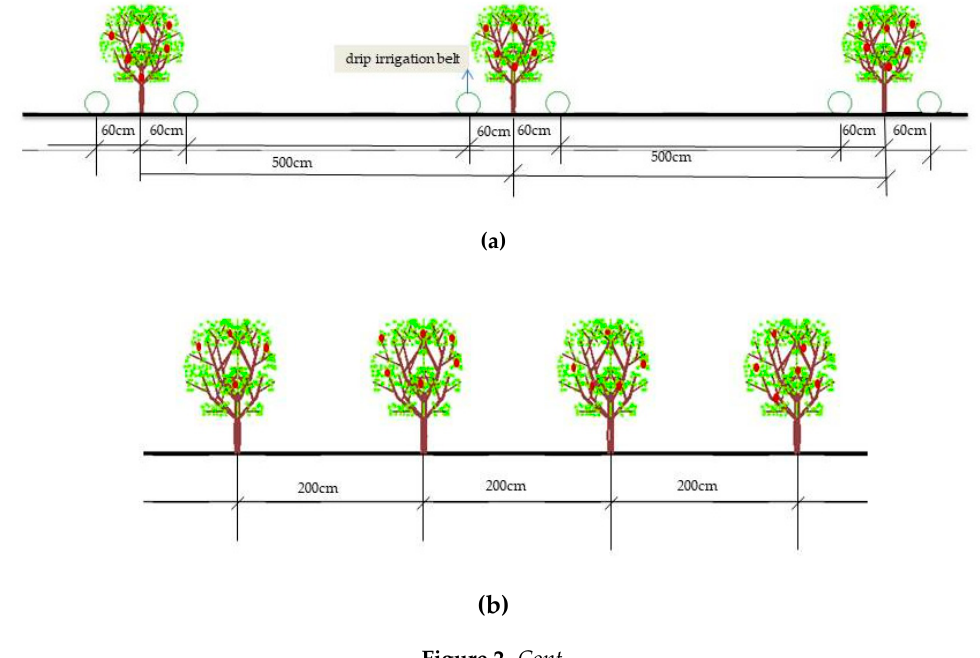
(c) Figure 2. Jujube row spacing in Xinjiang ( a ); jujube plant spacing in Xinjiang ( b ); jujube planting model in Xinjiang ( c ). 2.3. Measurements